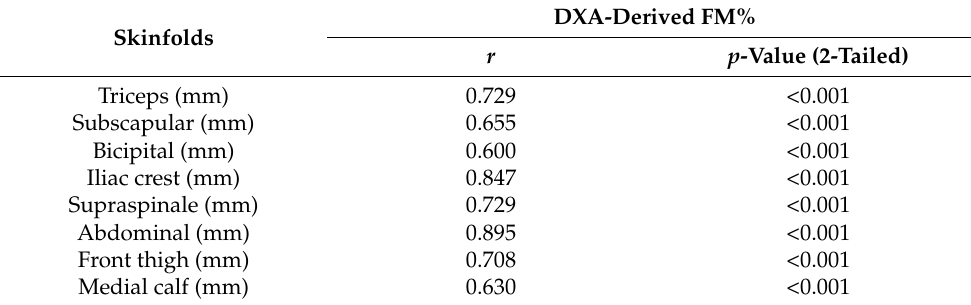
Table 3. Bivariate Pearson correlation analysis between skinfolds and fat mass percentage measured by dual-energy X-ray absorptiometry ( n = 78).